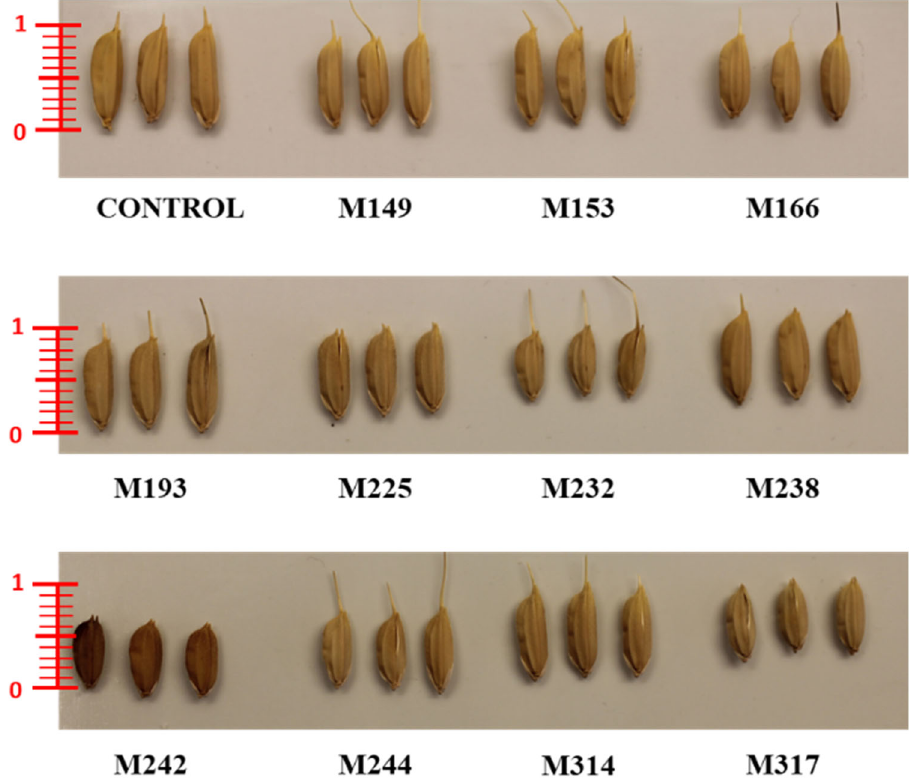
Figure 2. Grain length and color variation in rice mutant lines (scale used cm).